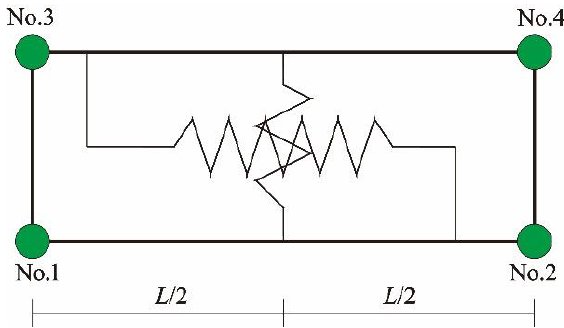
Figure 4. Goodman contact element model .